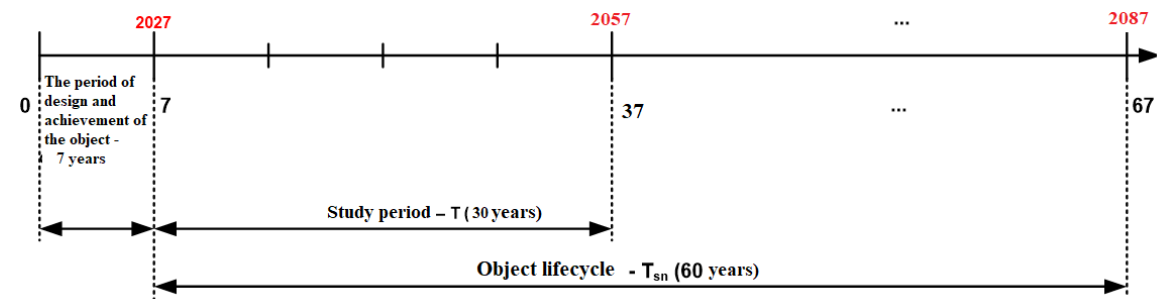
Figure 10. Time axis with the appropriate the time